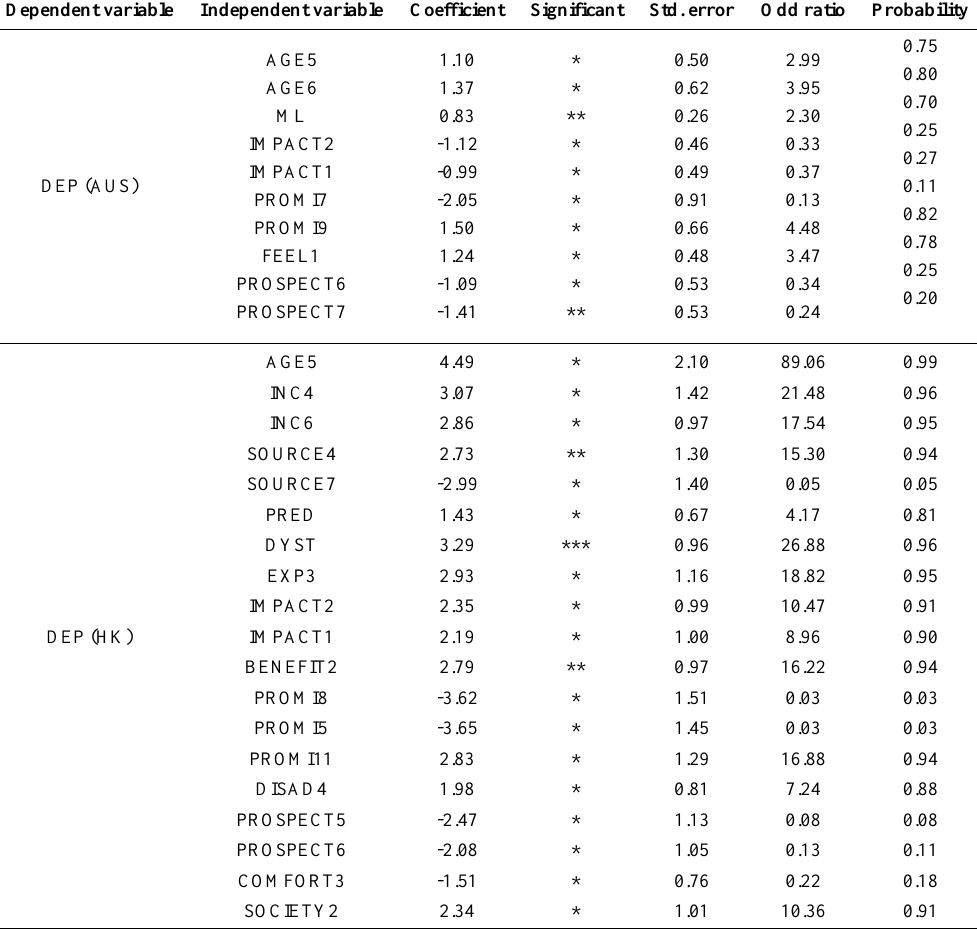
Table B-6. Heavy dependency of the AI technology companies/consultant for project/service